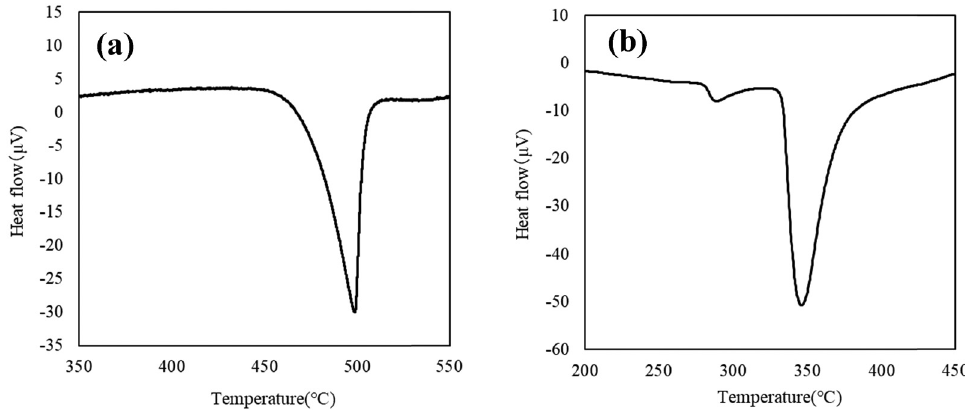
Figure 3: Melting curve of alloys with obtained eutectic compositions. ( a ) Al – Si – Cu – Mg – Zn and ( b ) Zn – Al – Mg – Sn.